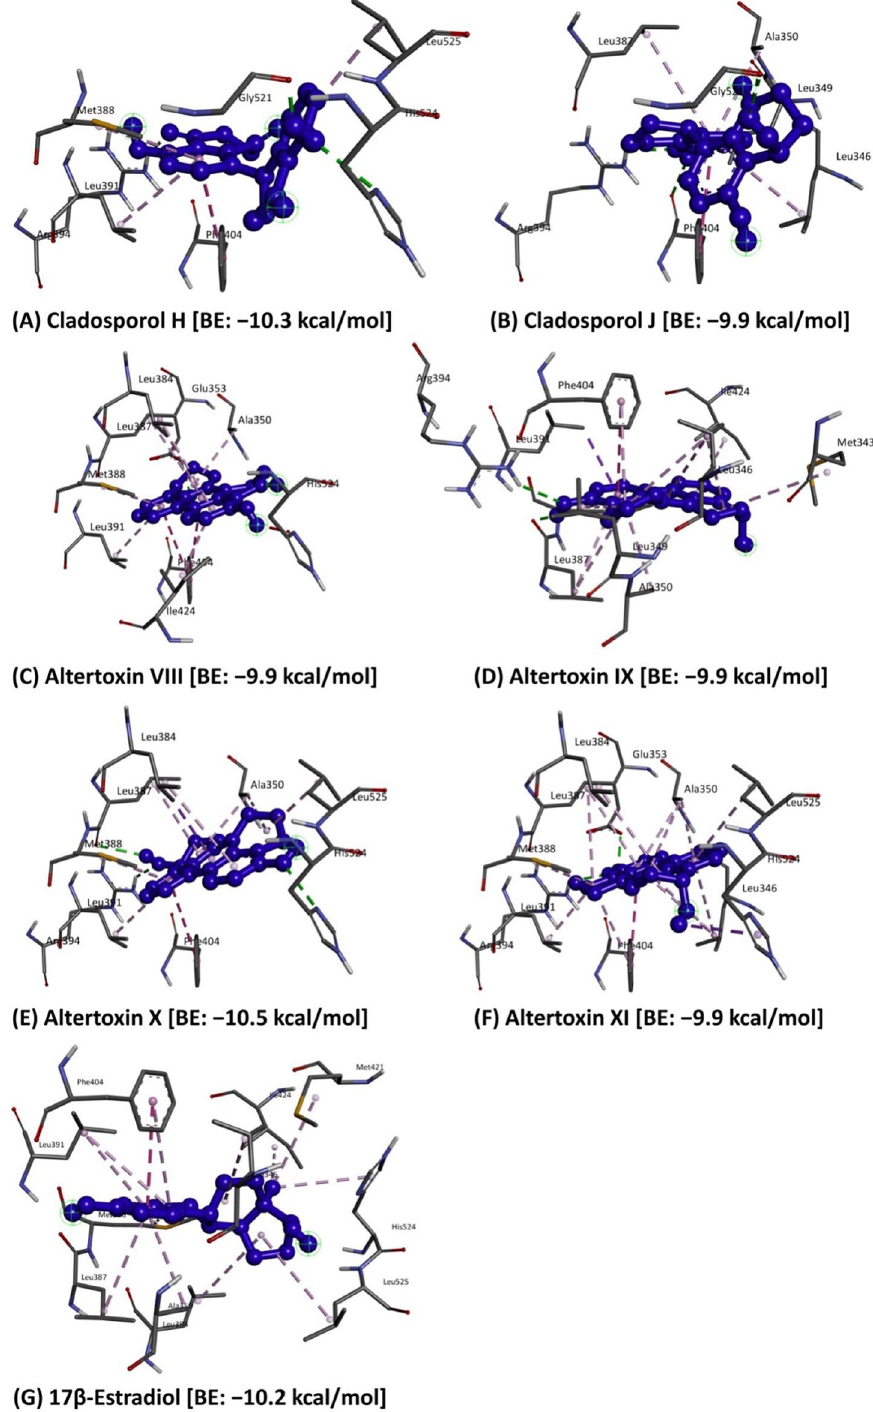
Figure 1. Docking model of the potential bioactive compounds of Cladosporium spp. in the active binding site of the estrogen receptor alpha (PDB: 6CBZ)